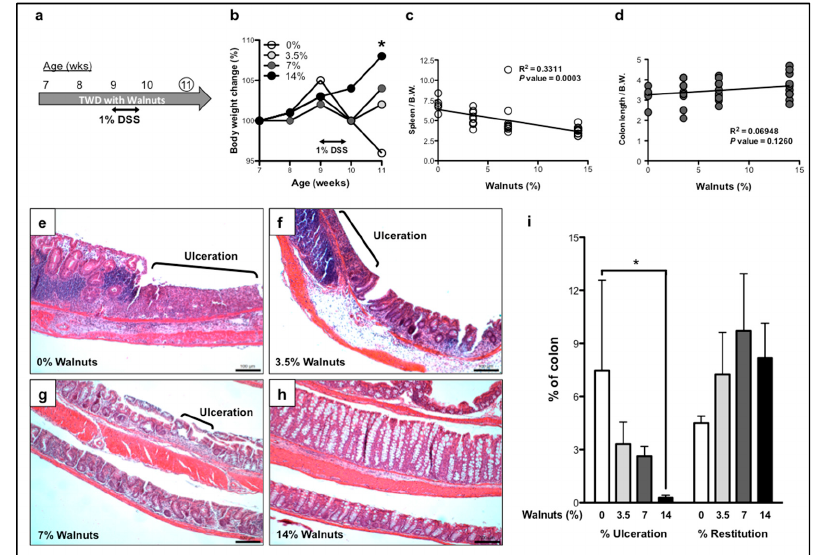
Figure 2. Effects of walnut supplementation on the recovery from dextran sodium sulfate (DSS)-induced colitis. ( a ) Experimental design for the recovery phase study. Total Western Diet (TWD) supplemented with 0, 3.5, 7 or 14% walnuts was started two weeks prior to the administration of 1% DSS. Mice were sacrificed 10 days after the withdrawal of DSS. The effects of walnut supplementation were examined on the following clinical endpoints: body weight change ( b ), linear-regression analyses of spleen weight ( c ) and colon length ( d ). The effects of walnut concentration on recovery from DSS induced colitis is shown for 0% ( e ) 3.5% ( f ) 7% ( g ) and 14% walnuts ( h ). The extent of ulceration and restitution were scored as the percent of the entire length of colon for each group ( i ). Bars represent the means ± SEM. n = 6 for 0%, n = 9 for 3.5% and n = 10 for 7% and 14%. * One-way ANOVA with Bonferroni’s multiple comparison tests, p < 0.05.